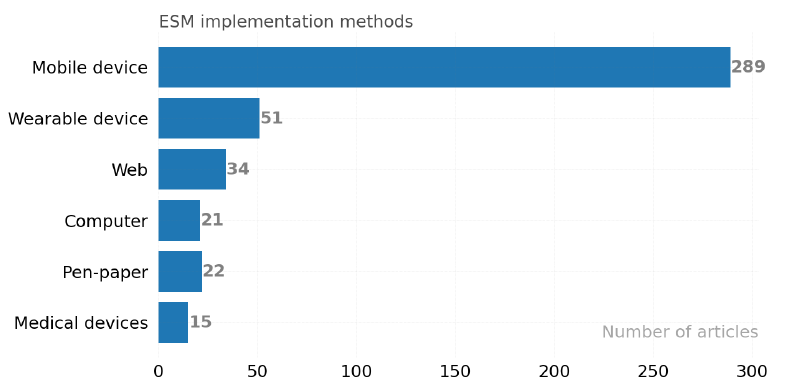
Figure 3. Platforms/Devices used to collect data in